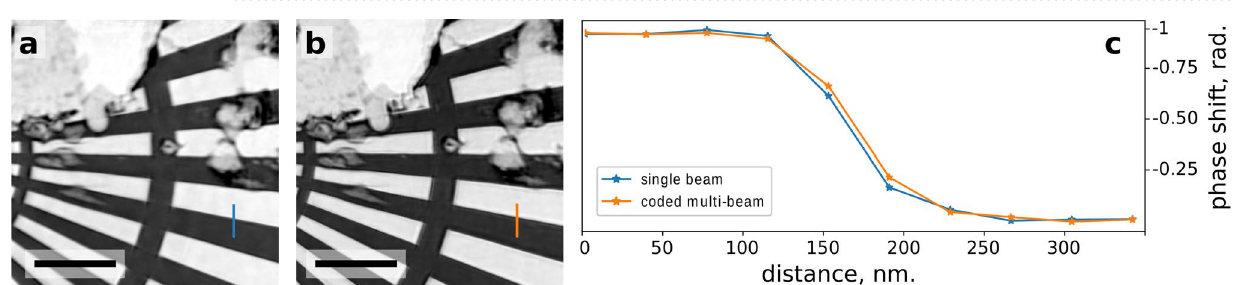
Figure 4. Evaluation of the resolution using line profiles. ( a ) Measurement with a single probe, ( b ) measurement with two coded probes, ( c ) corresponding profiles. The full width at half maximum value for the single beam profile is 64 nm and for the two beam profile 68 nm. The scale bars represent 3